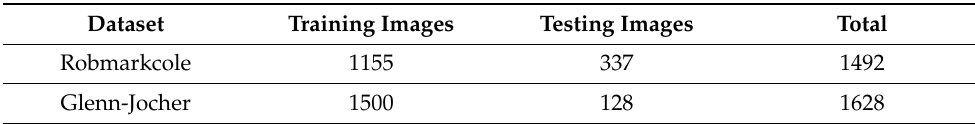
Table 1. Distribution of fire images in the